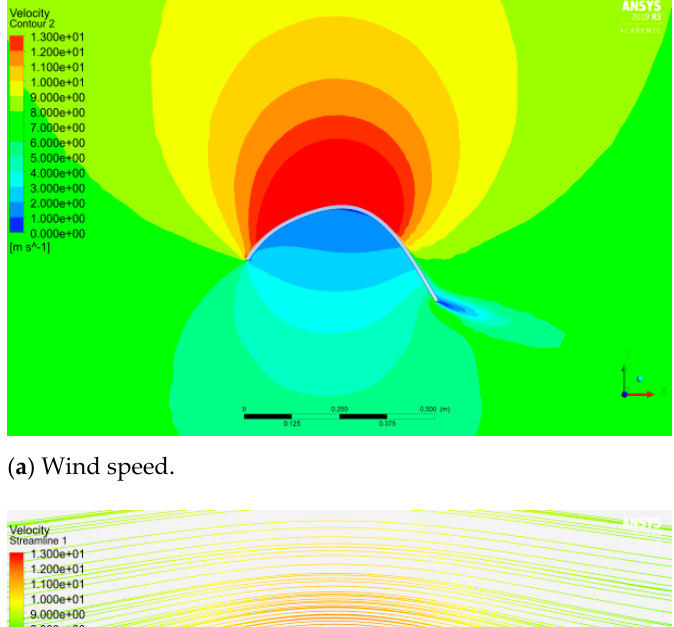
Figure 5. Wind speed distribution along the rotor plane.